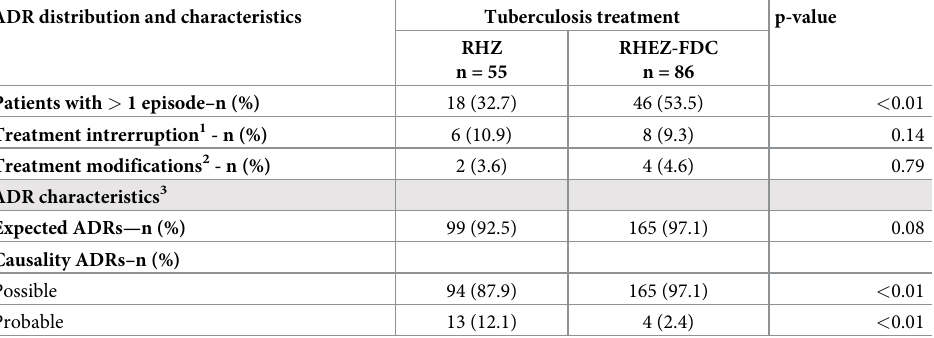
Table 2. Distribution and characteristics of adverse drug reactions (ADRs) of tuberculosis